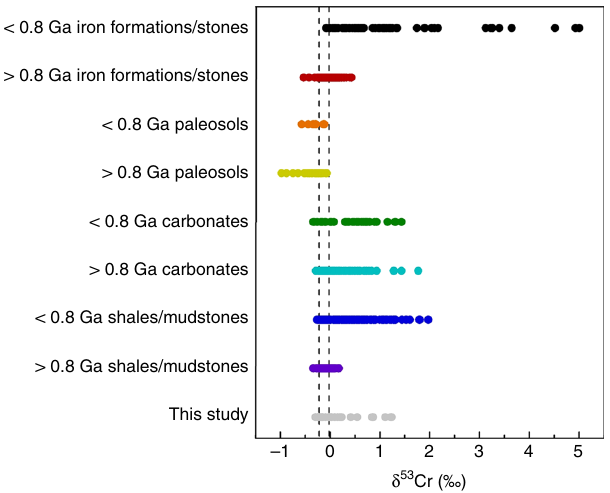
Fig. 5 Cr isotope fractionation vs metal – ligand stability constant. Δ 53 Cr (de fi ned as Δ 53 Cr = δ 53 Cr solution − δ 53 Cr starting solid ) at pH 7 and ionic strength of 0.1 M as a function of the stability constant of the corresponding Fe(III) – ligand complex. The data points for each condition represent complete harvests at various times throughout the experiment. Stability